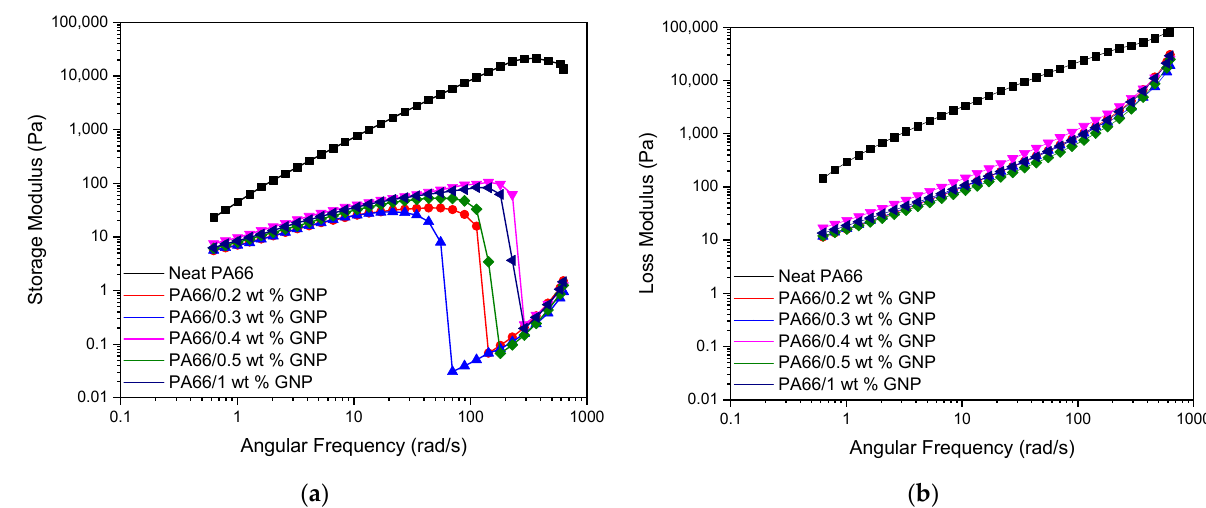
Figure 9. Change in storage moduli ( a ) and loss moduli ( b ) of neat PA66 and PA66/GNP nanocomposites.